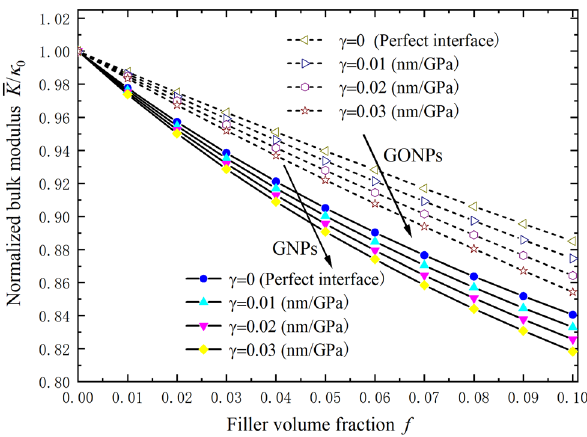
Figure 3: The relationship between the normalized bulk modulus of the nanoplate composites with the volume fractions and interface sliding parameters.